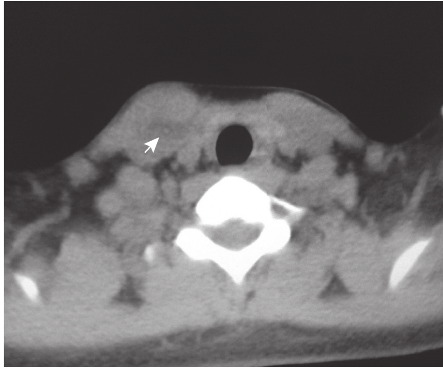
Figure 2: Axial noncontrast computed tomography image of the neck at the level of T1 vertebra showing slightly hypodense cystic lesion with a small area of hyperdensity within the lesion